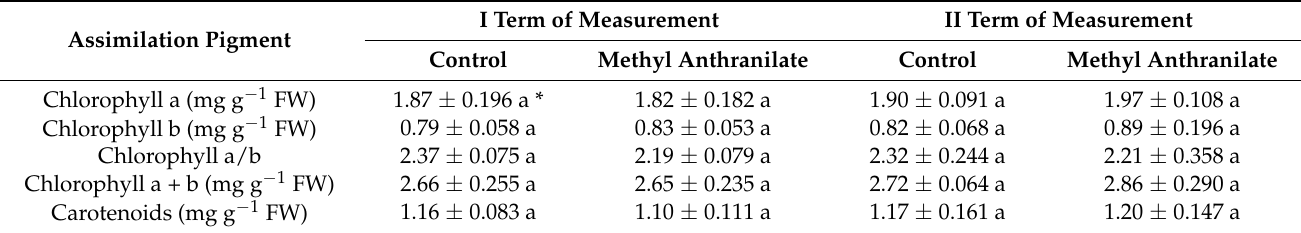
* Data are presented as mean ± SD. Means assigned identical letters do not differ significantly at the level of significance p = 0.05. The conducted study did not demonstrate that the repellent affected the intensity of CO 2 assimilation and transpiration or the photosynthetic water use efficiency in photosyn- thesis for the leaves of sweet cherry cv. ‘Burlat’ (Table 5). The CO 2 assimilation and transpi- ration intensity ranged from 10.4 (2nd date of measurement, control) to 11.9 µ mol m − 2 s − 1 (1st date of measurement, methyl anthranilate) and from 1.84 (2nd date of measurement,